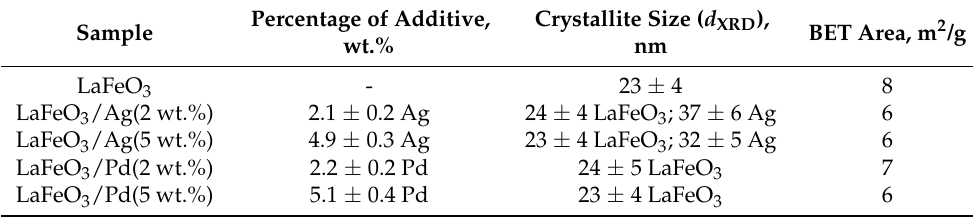
Figure 1. XRD patterns of pristine and Ag- or Pd-modified LaFeO 3 . Table 1. Composition and microstructural parameters of